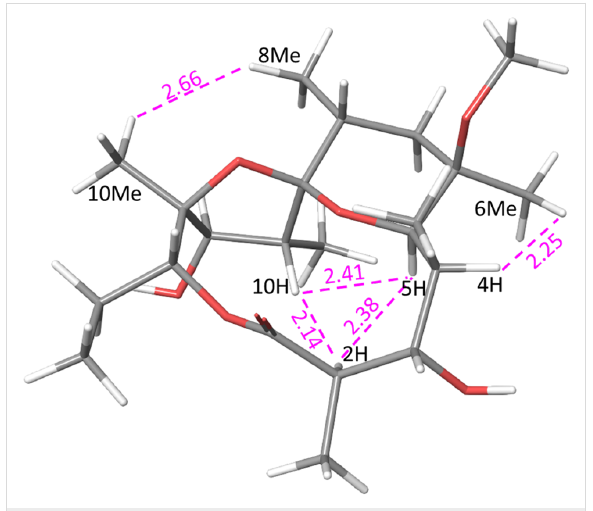
Figure 1: Modelling-derived structure of 2 showing key nOe interac- tions (calculated distances in